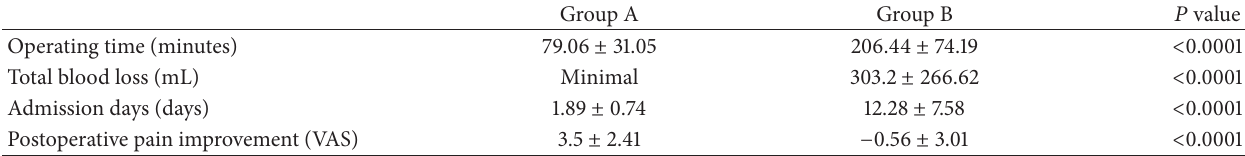
Table 2: Summary of clinical outcomes who underwent PELD (Group A) and open lumbar surgery (Group